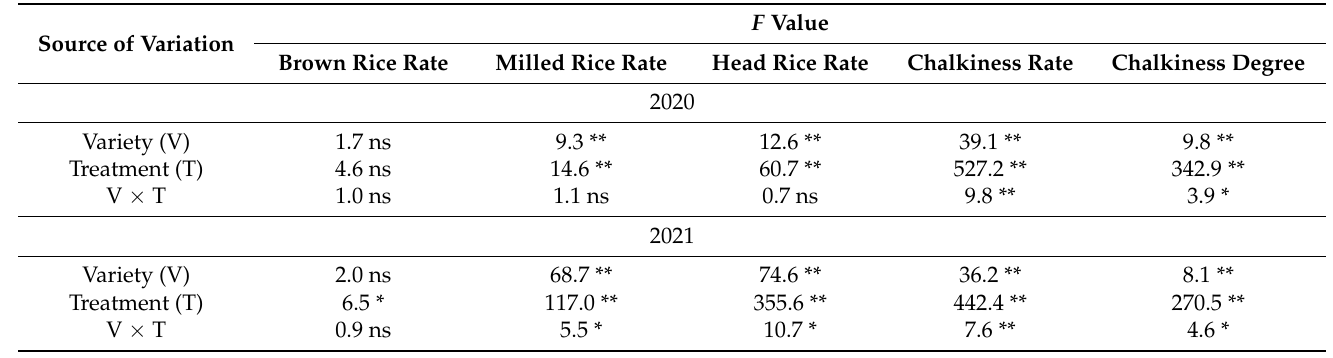
Table 4. Variance analysis of processing and appearance quality of different rice varieties under shading after flowering in